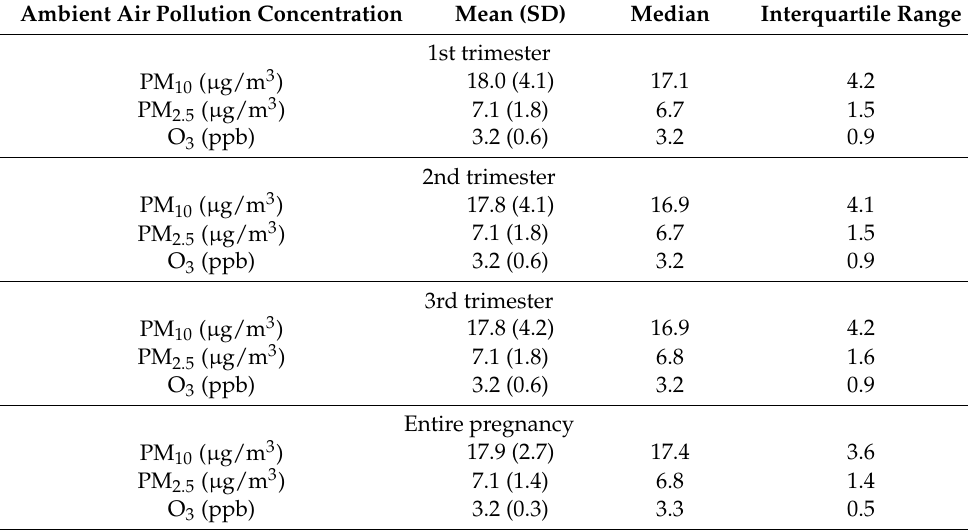
Table 2. Mean, standard deviation (SD) and median ambient air pollution concentrations by trimesters and entire pregnancy, Sydney, Australia,